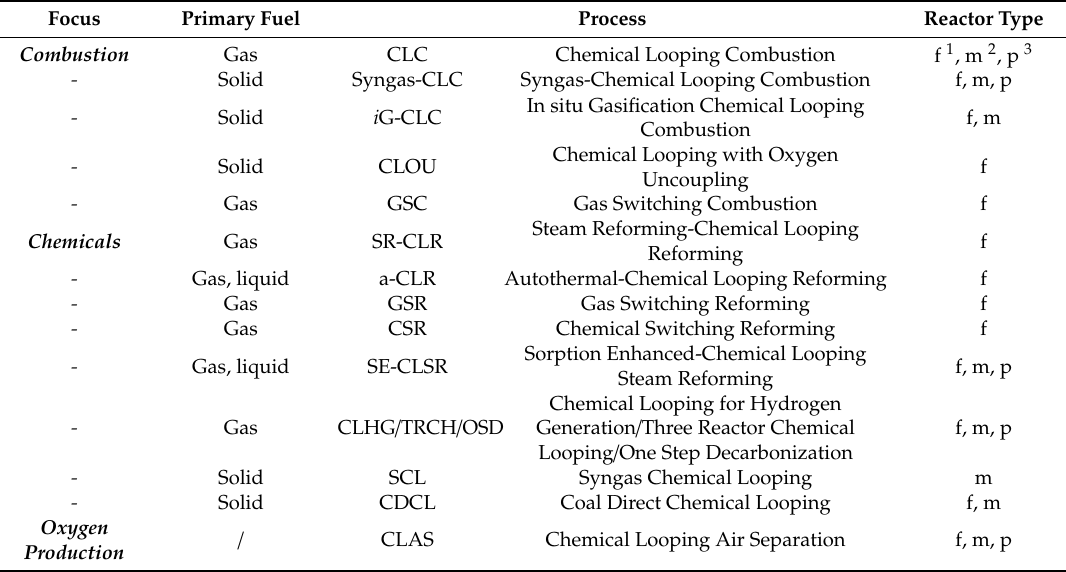
Table 2. An overview of some of the di ff erent chemical looping technologies found in the